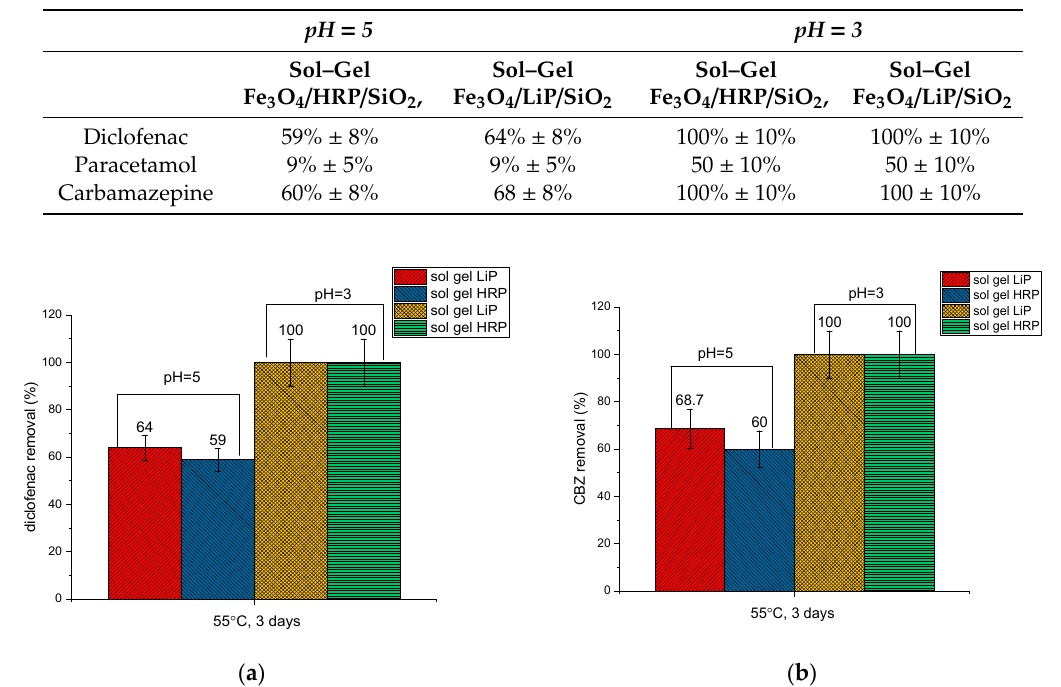
Figure 9. NMR spectra of initial CBZ ( a ), CBZ after interaction with sol–gel encapsulated LiP ( b ), and HRP ( c ) at pH = 3 over 3 days. Table 1. Activity of LiP and HRP composites in drug decomposition processes over 3 days, 55 ◦ C at di ff erent pHs.